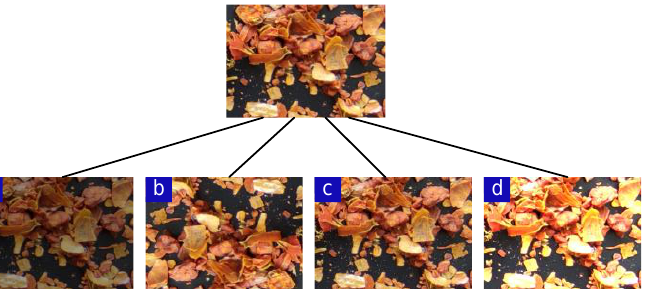
Figure 3. Example of image cropping process. The image on the left is the original, and the image on the right comprises the nine cropped images.